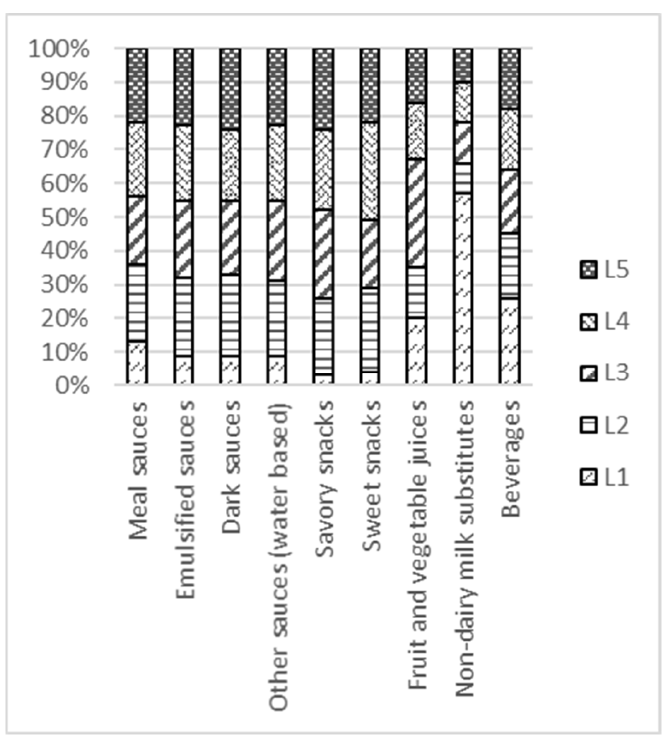
Figure 6. Distribution of products in the database over levels L1–L5 for non-basic food groups. As WHO NPs did not provide a benchmark for T3, the distribution over levels 1–5 is much more even than for basic food groups.